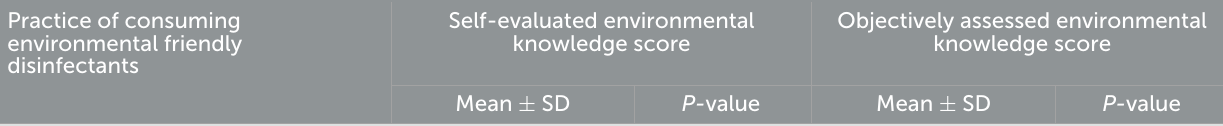
TABLE 2 Association between the practice of consuming environmental friendly disinfectants and the self-evaluated or objectively assessed environmental knowledge regarding disinfectants among participants ( n = 1,861).